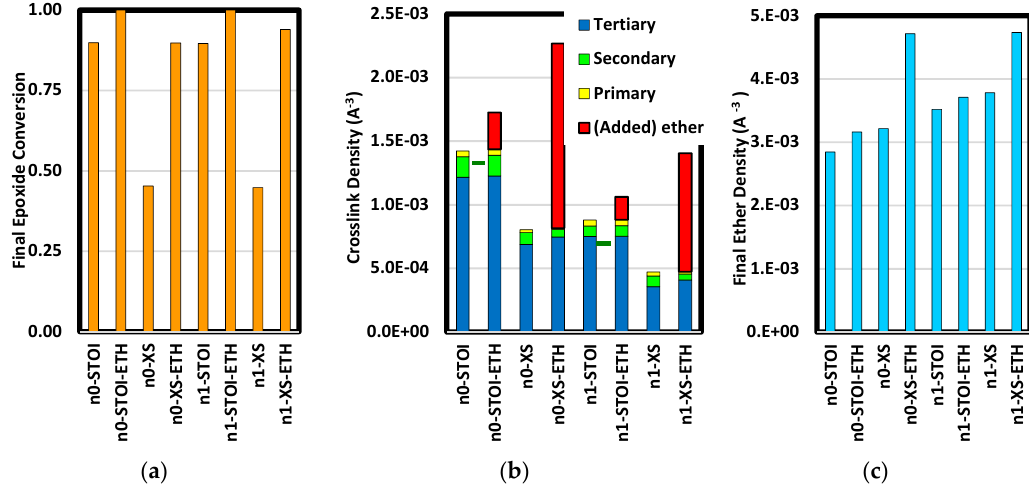
Figure 7. Results of amine addition and etherification on epoxide conversion ( a ), crosslink density ( b ), and total ether density ( c ). The green fiducial marks in ( b ) are values measured by Glad and Kramer [53] for amine-cured systems using methylene diamine as the curing agent. Mass density, stiffness, and strength are commonly found to correlate with crosslink density.